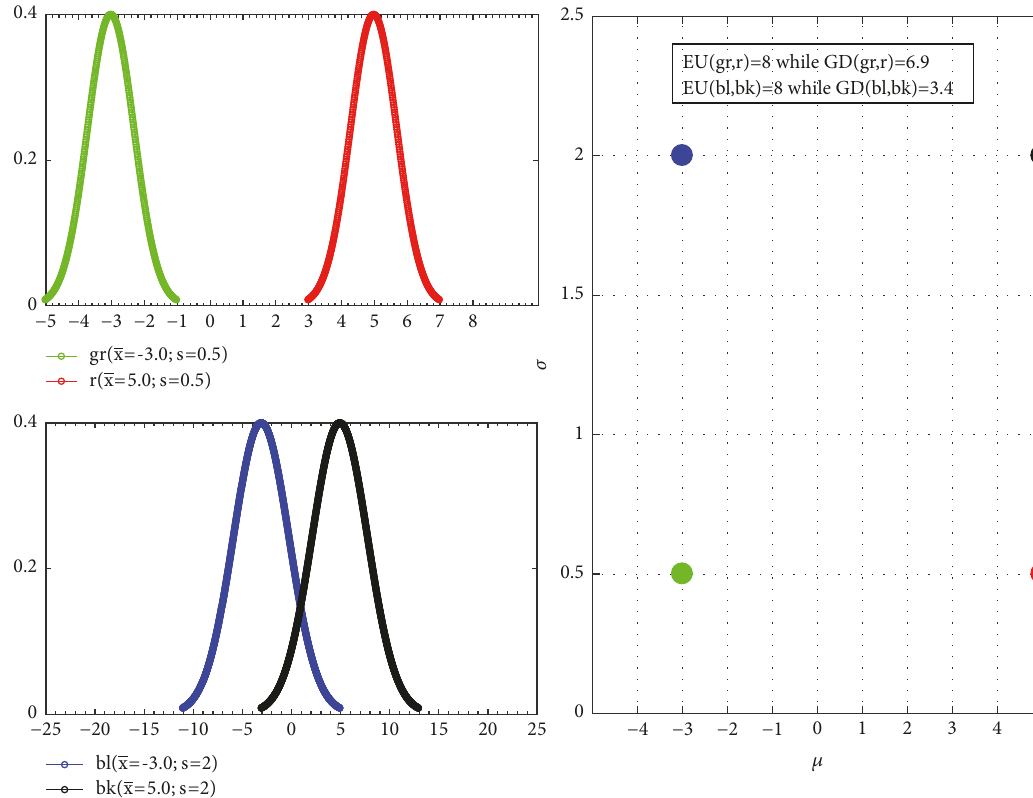
Figure 2: Examples to illustrate how the GDGM determines the distance between two Gaussians. The two couples of pdfs in the figure have the same mean but different 𝑠 . The geodesic distance between the two with higher 𝑠 is much smaller (see insert).